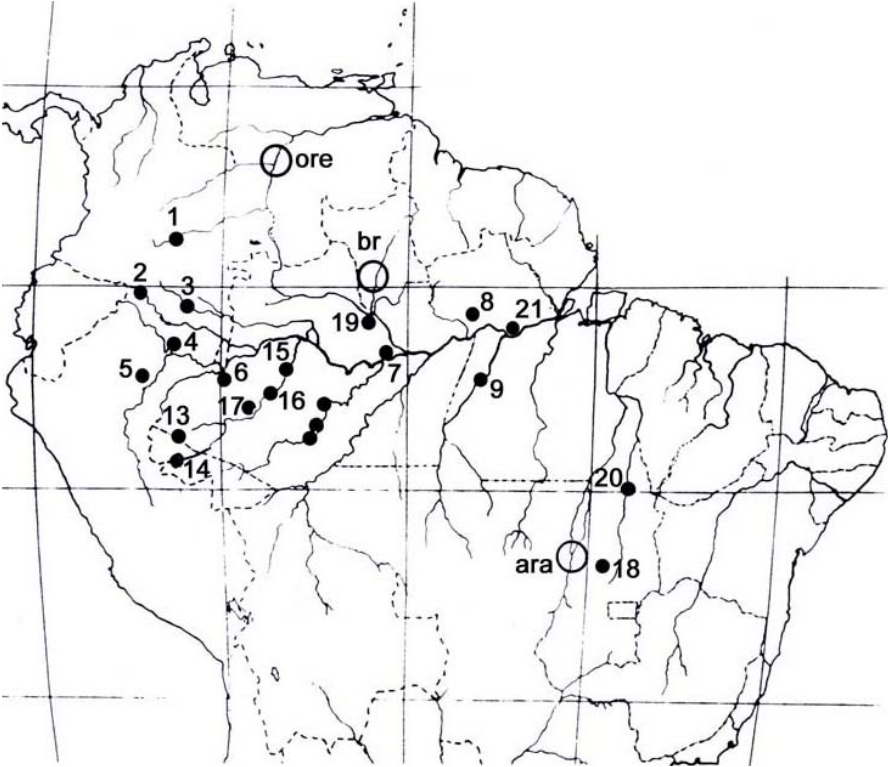
Fig. 2 – Beaches mentioned. 1, Rio Ariari. 2, Isla Vieja. 3, Rio Caquetá (Centro; Guadual;